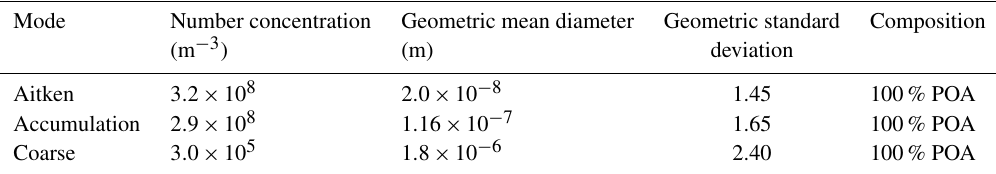
Table 11. Initial aerosol-phase conditions for box model simulations (“remote continental” case in Seinfeld and Pandis, 2016, Ch. 8). POA stands for primary organic